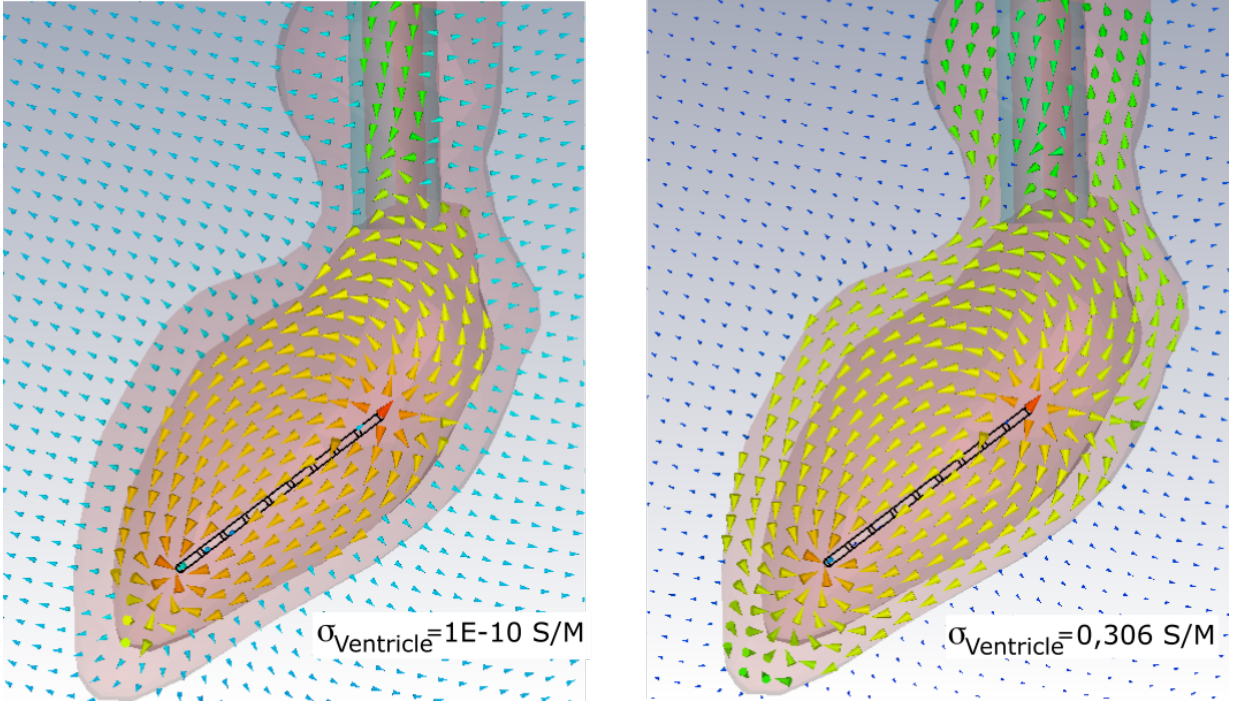
Fig.5: Close-up of the current paths in the ventricle with insulating properties (left) and conductive properties (right).